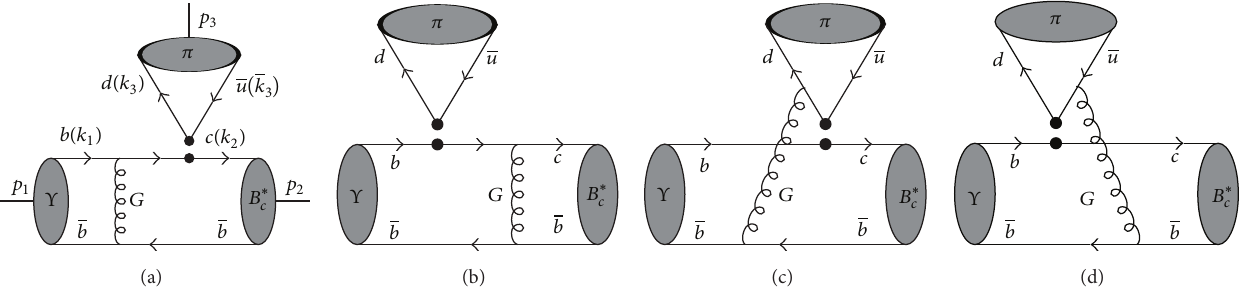
Figure 2: Feynman diagrams for Υ(𝑛𝑆) → 𝐵 ∗ 𝑐 𝜋 decay with the pQCD approach, including factorizable emission diagrams (a, b) and nonfactorizable emission diagrams (c,